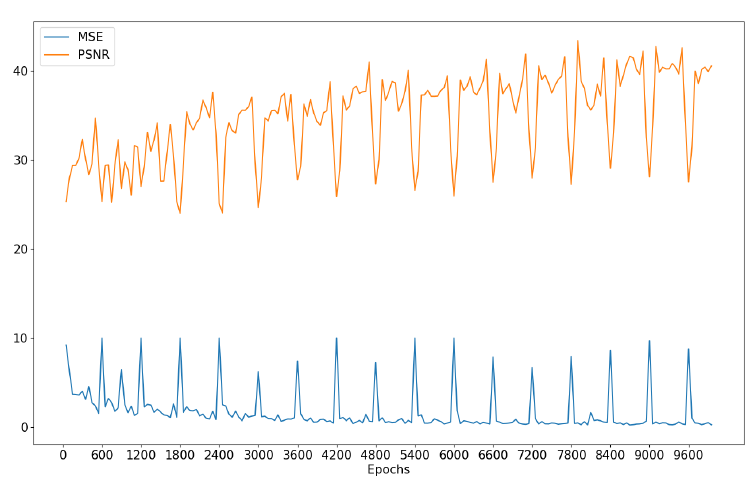
Figure 7. Curves of L DR and PSNR with